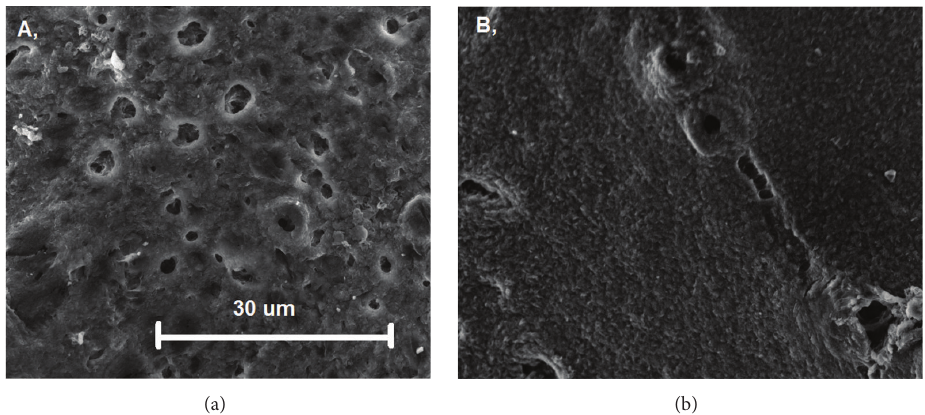
Figure 4: The SEM surface images (5000x magnification) of treated membranes using different extraction solvents: (a) AEM coated with surface on membrane 1 after the extraction in THF and (b) AEM coated with surface on membrane after the extraction in THF.